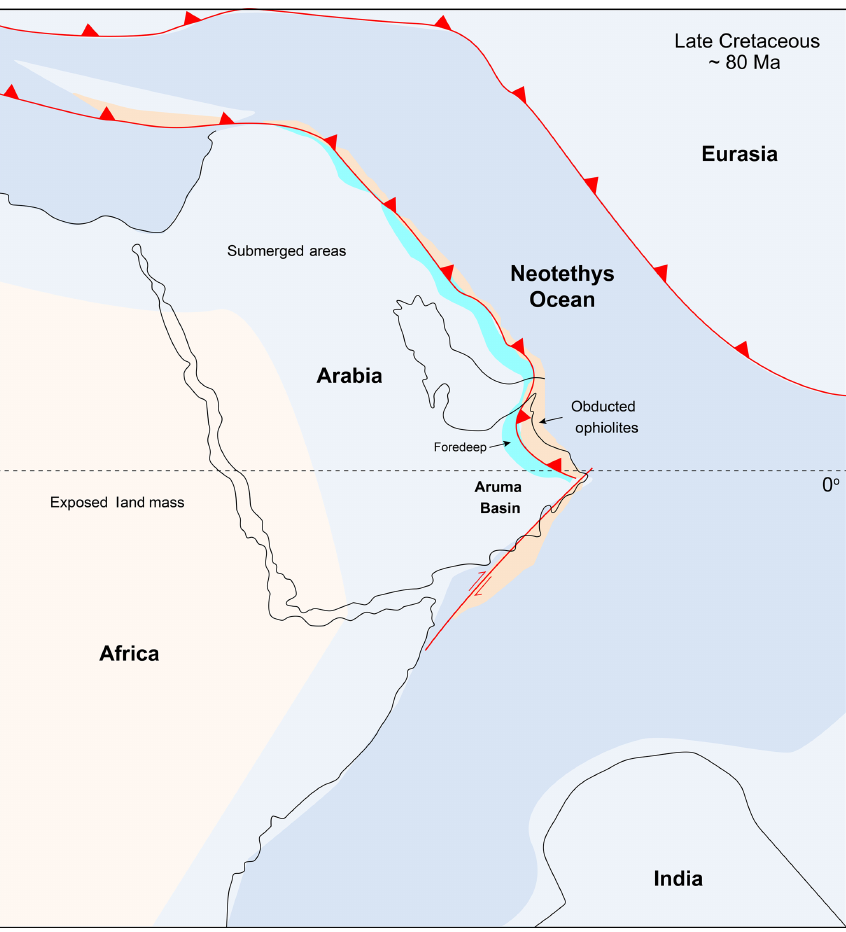
Figure 1. Palaeoceanographic and tectonic reconstruction of Arabia showing the location of the Aruma Basin. Modified from Barrier and Vrielynck (2008) with information from van Hinsbergen et al.